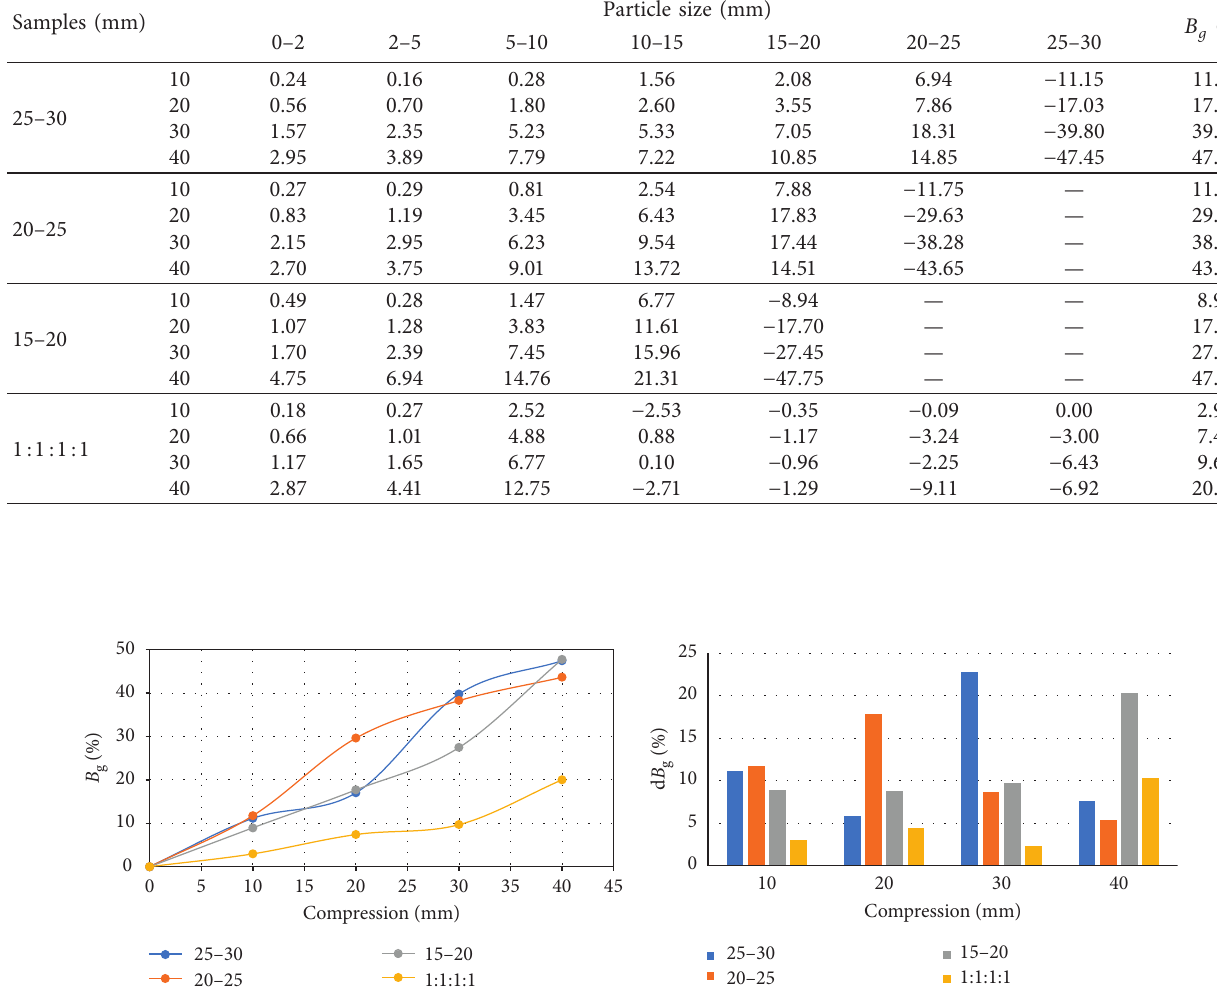
Table 4: The particle size content and particle breakage for samples with different compaction levels. Samples (mm)